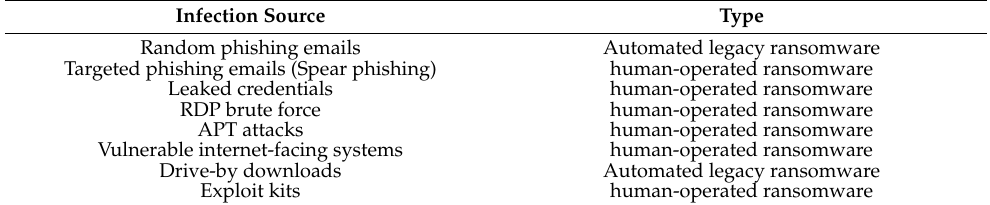
Figure 2. Ransomware infection vectors. Table 3. Ransomware infection source